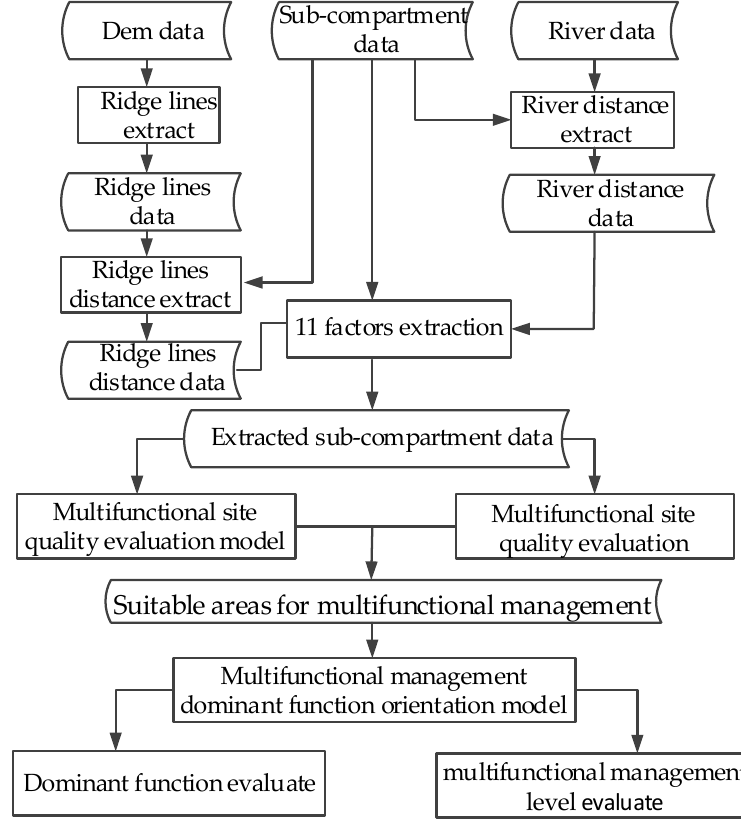
Figure A1. Methodology flow chart. Table A2. Results of multifunctional suitability assessment. (IE—important index of ecological status;